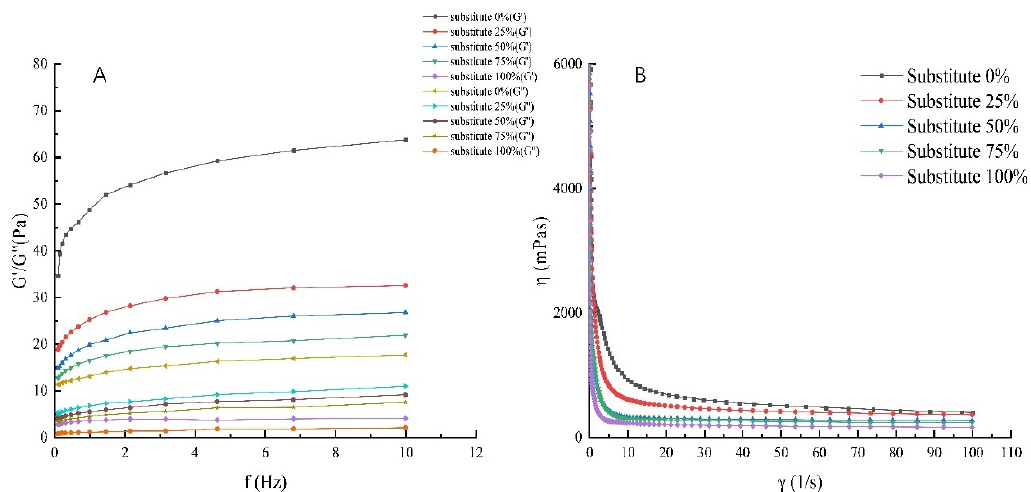
Figure 1. Effect of replacing milk fat by SOB on rheological properties of yogurt: ( A ) Curves of elastic modulus and viscous modulus of yogurt with different substitution amount; ( B ) The relationship between apparent viscosity and shear rate of yogurt with different substitution amount.